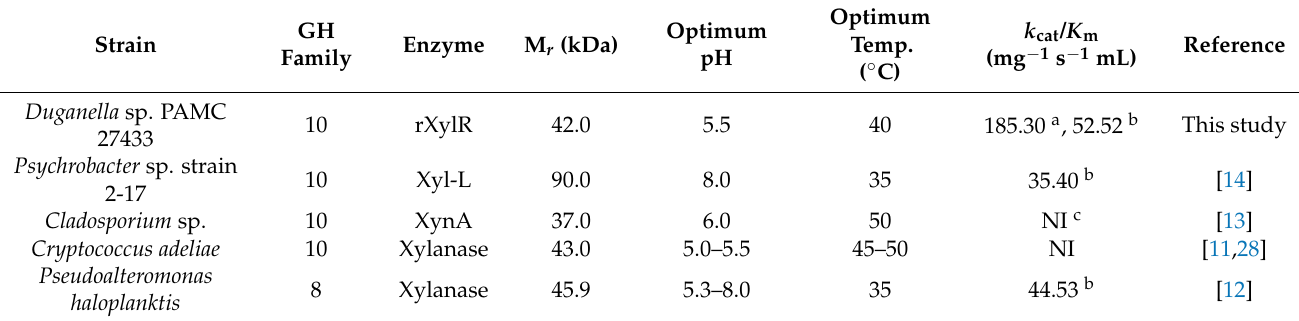
Table 1. Biocatalytic characteristics of cold-adapted or cold-active endo- β -1,4-xylanases from Antarctic microorganisms.